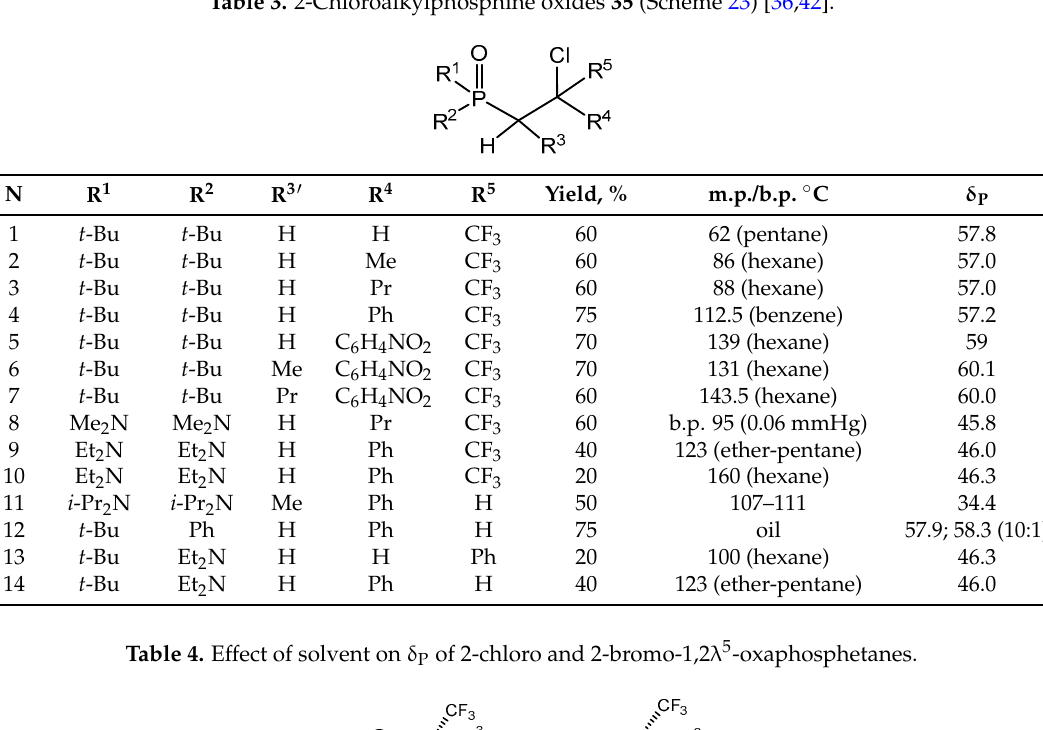
Table 3. 2-Chloroalkylphosphine oxides 35 (Scheme 23) [36,42].